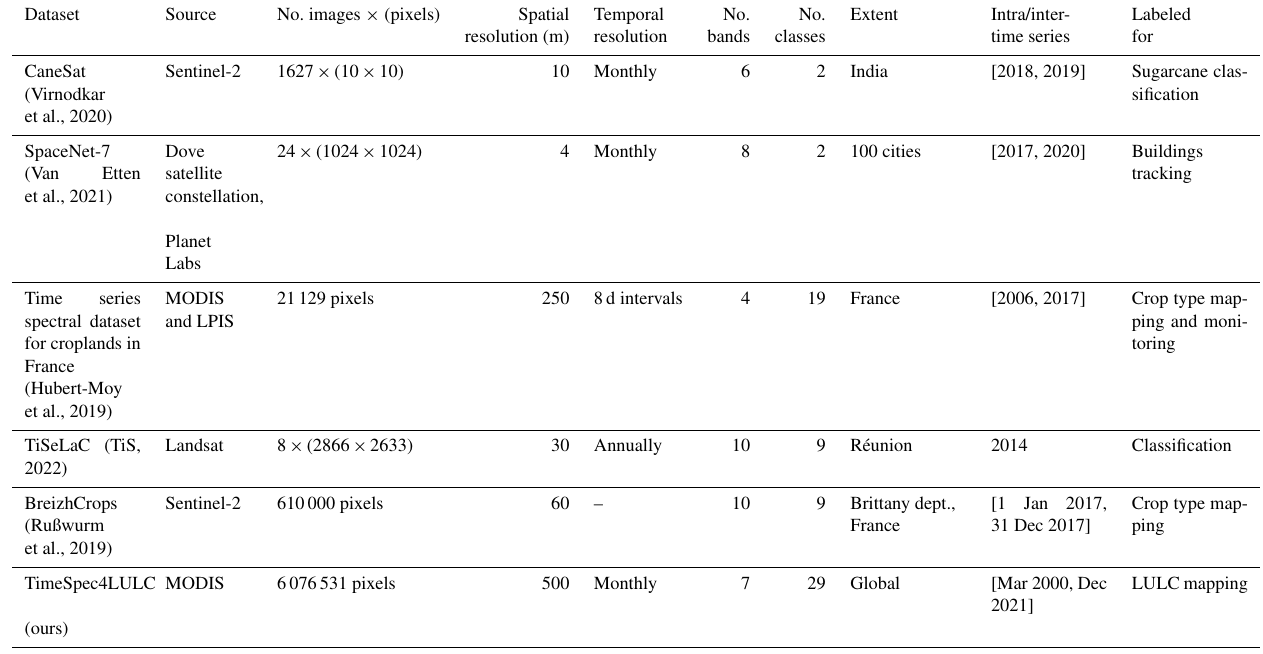
Table 1. A list of existing datasets of times series of satellite images, including the proposed TimeSpec4LULC dataset, for training machine learning